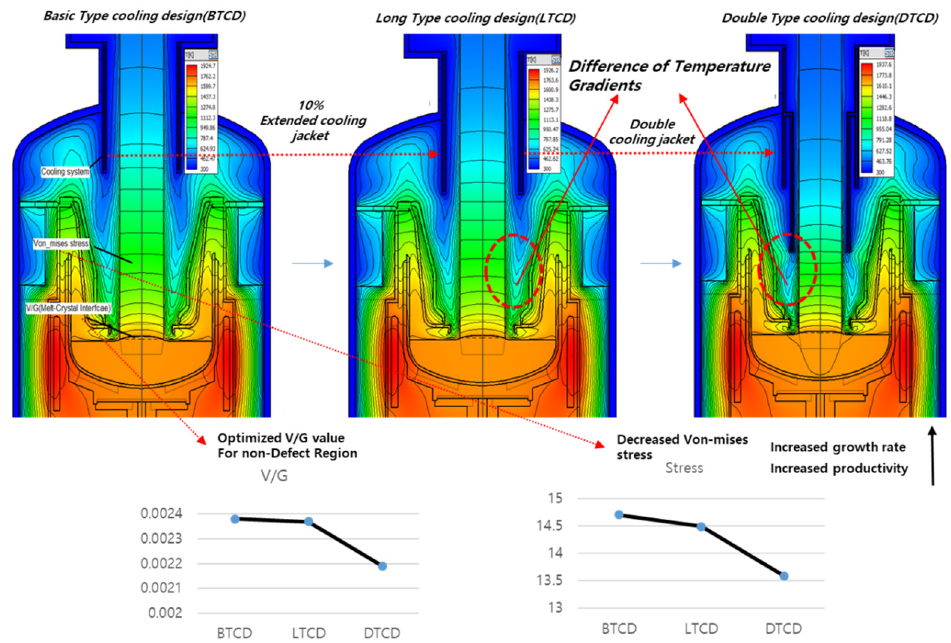
Figure 6. BTCD, long type cooling design (LTCD), and double type cooling design (DTCD) schematic diagram of the overall process of the water-cooling system in CG-Sim 2D view.